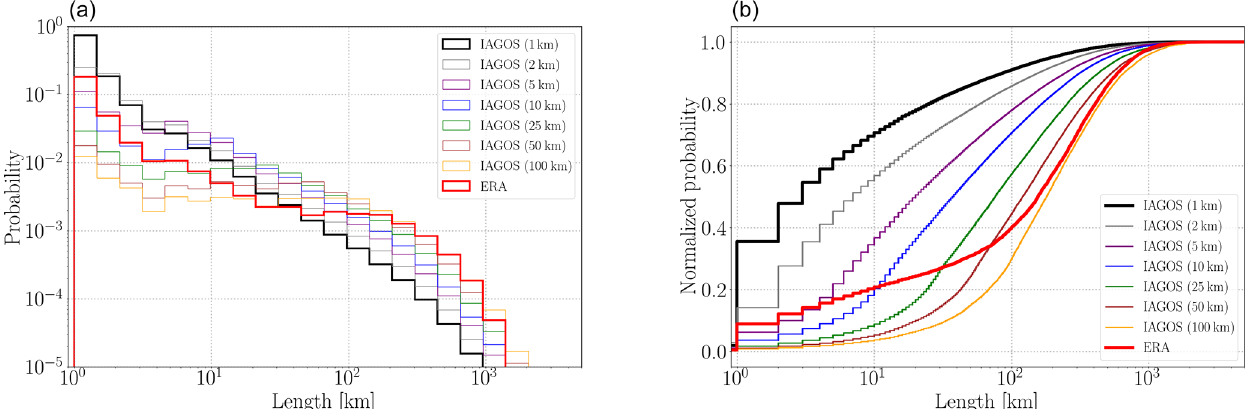
Figure 9. Probability of ISSR pathlengths with logarithmic binning (a) and cumulative probability (b) . The original IAGOS data are shown in black, while ERA is presented in red. Other colours denote different running means of the original IAGOS data set to mimic different spatial data